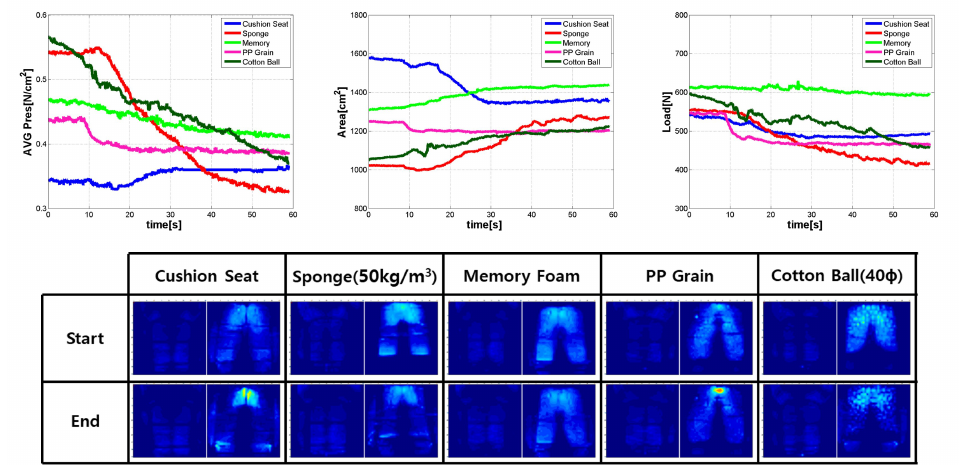
Figure 10. The result of the material selection test (all materials). Avg. pressure ( Up-Left ), Con- tact Area ( Up-Center ), Load ( Up-Right ), Init & Critical pressure map of each material seat.